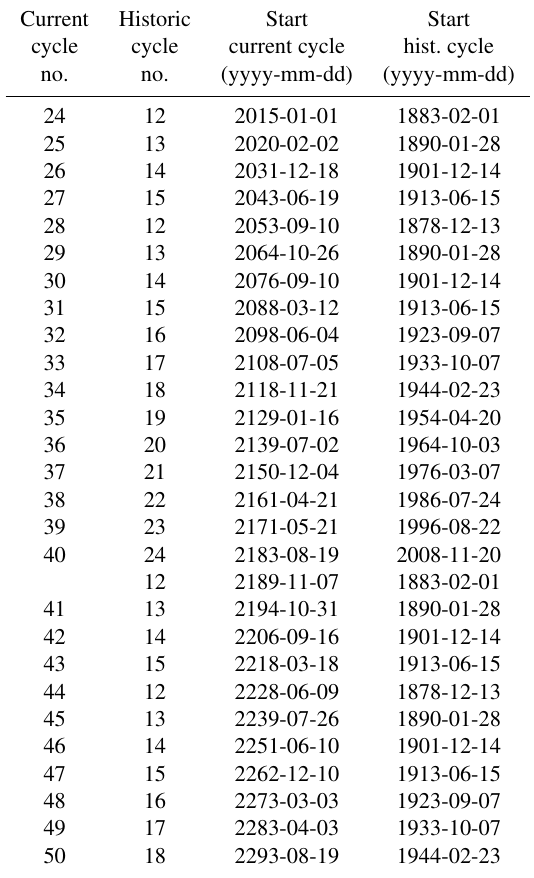
Table G1. Historical solar cycles used for construction of future cycles (starting on 1 January